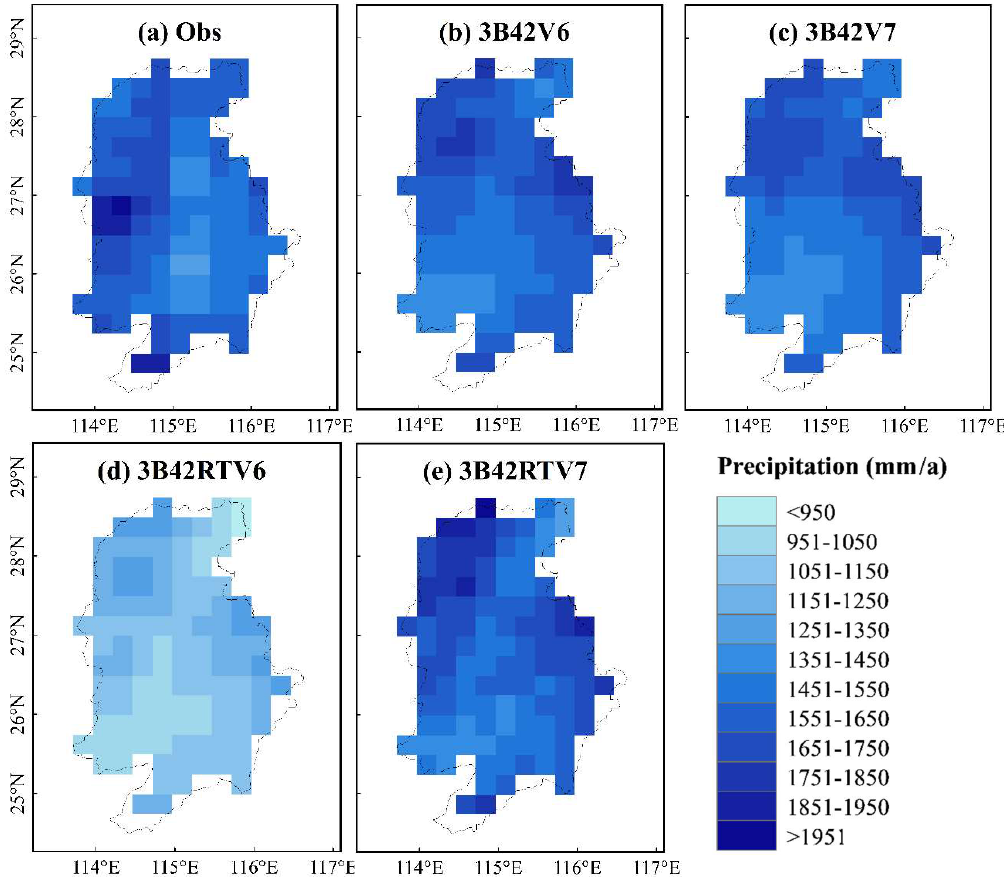
Figure 2. Spatial distribution of annual mean precipitation in the Ganjiang River Basin for TMPA and observed data from 2003 to 2010 ( a ) Observed data; ( b ) 3B42V6; ( c ) 3B42V7; ( d ) 3B42RTV6; ( e ) 3B42RTV7).